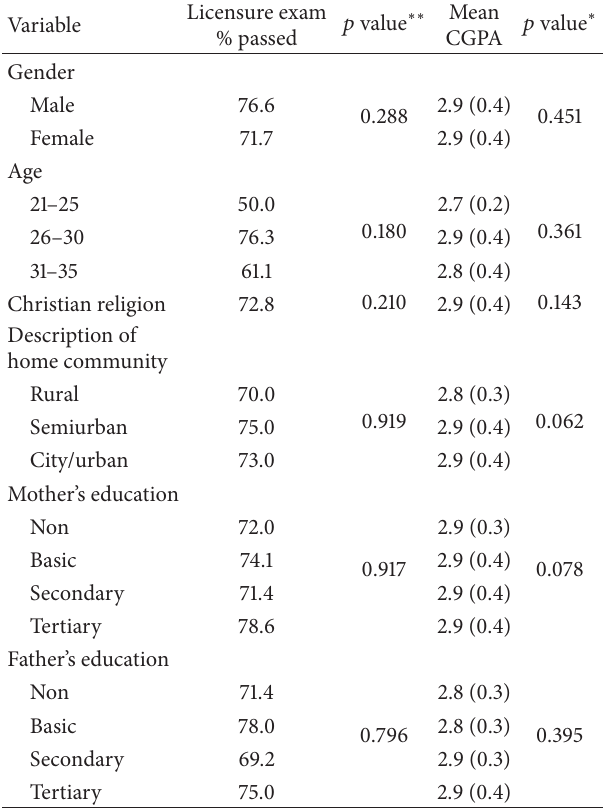
Table 3: Influence of sociodemographic characteristics on perfor- mance in licensure